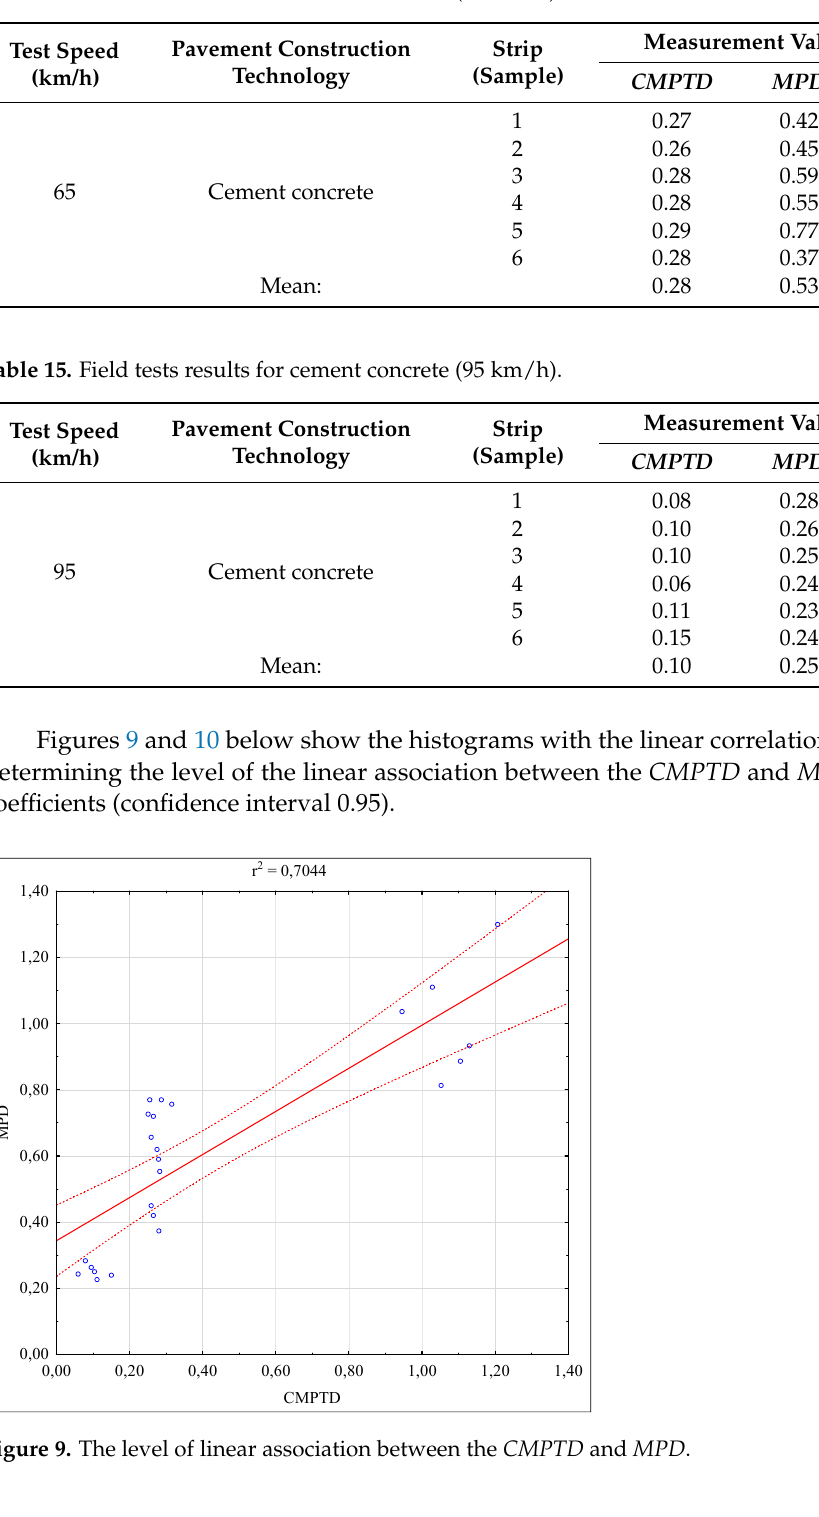
Table 14. Field tests results for cement concrete (65 km/h).